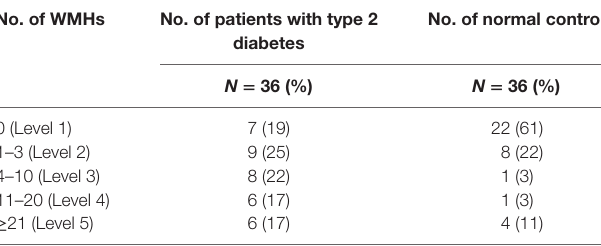
Numbers in parentheses represent percentages.